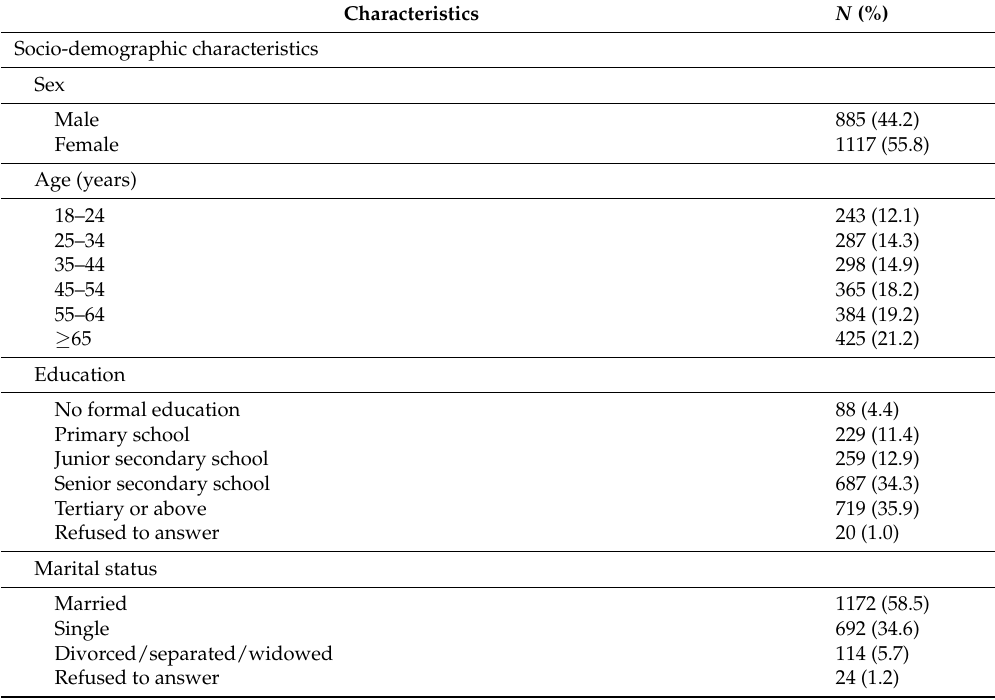
Figure 1. Flowchart of the study. Table 1. Characteristics of participants ( N = 2002).